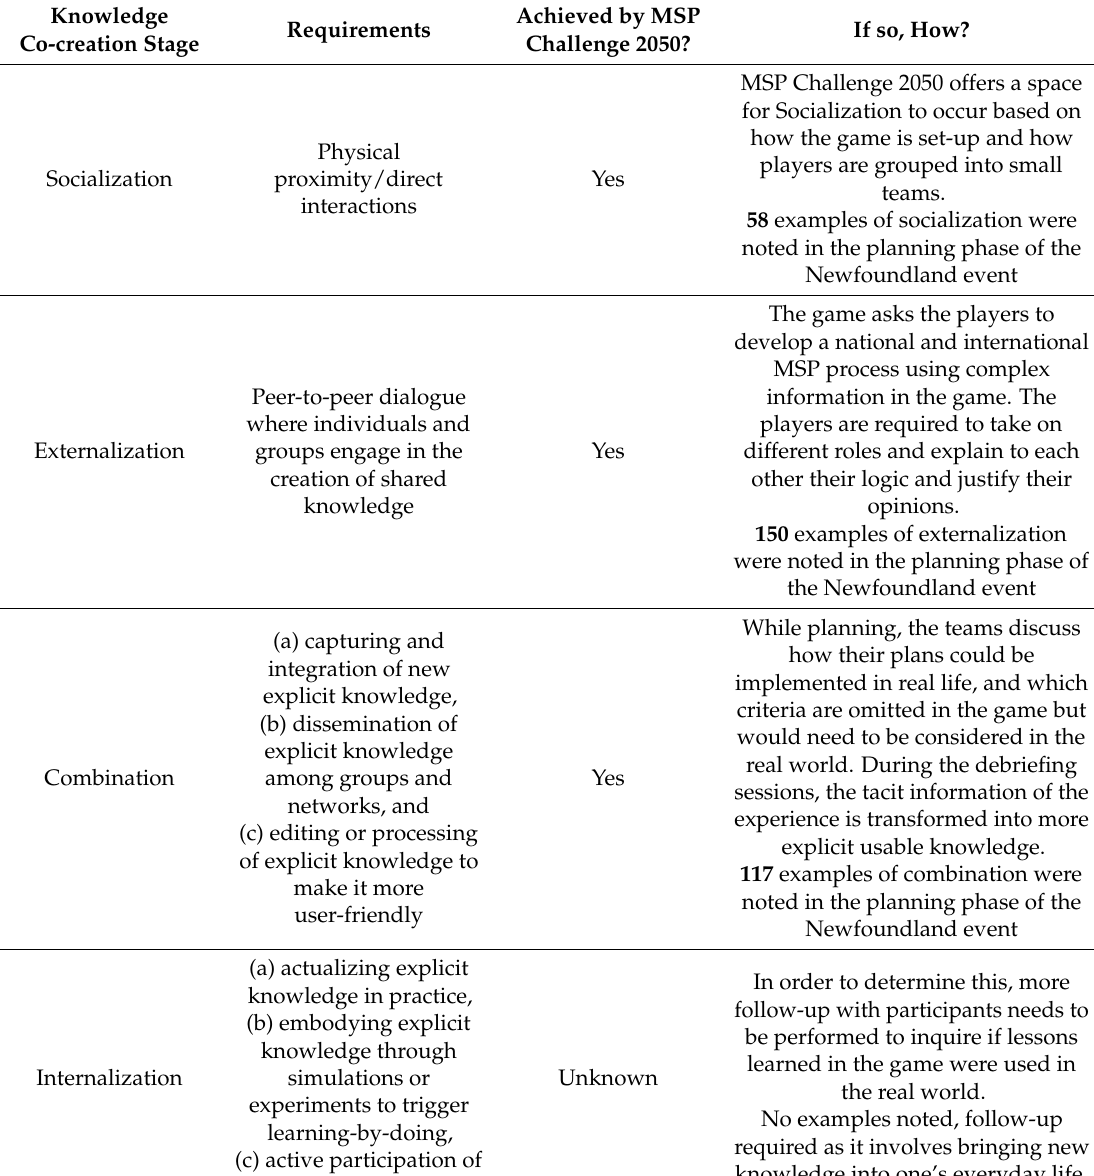
Table 10. Evidence of knowledge co-creation occurring during MSP Challenge 2050